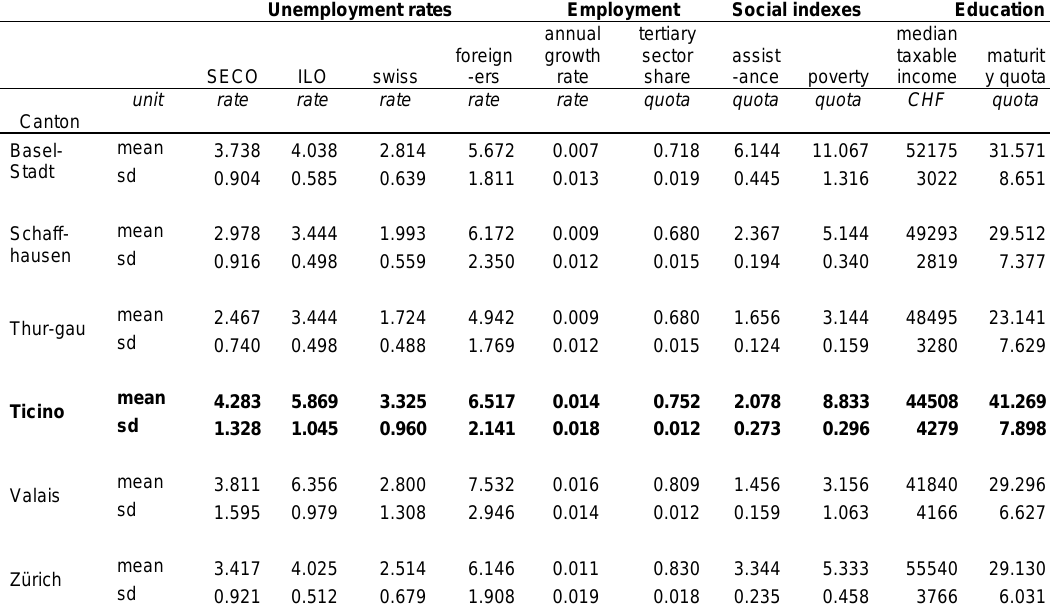
Table 1. Descriptive statistics for Ticino and cantons composing the SC for Ticino. Unemployment rates